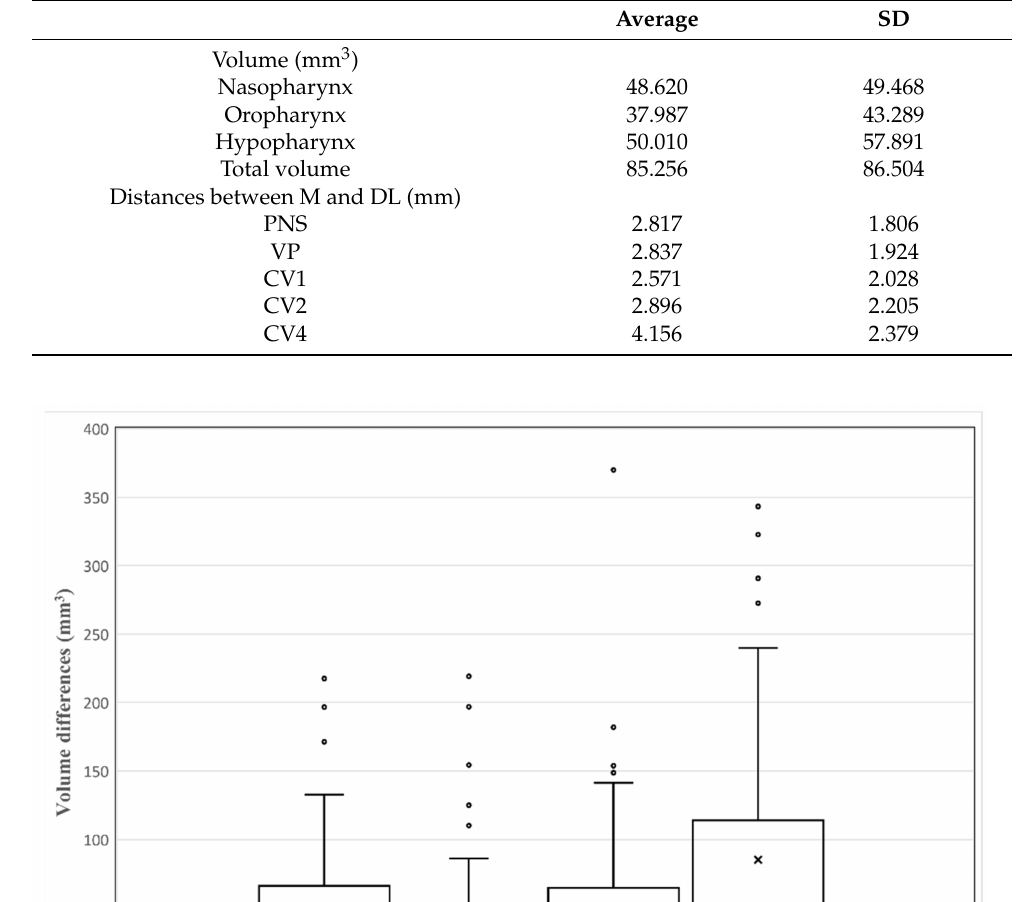
Table 2. Measurements of the differences between manual analysis and deep learning analysis (N = 61).